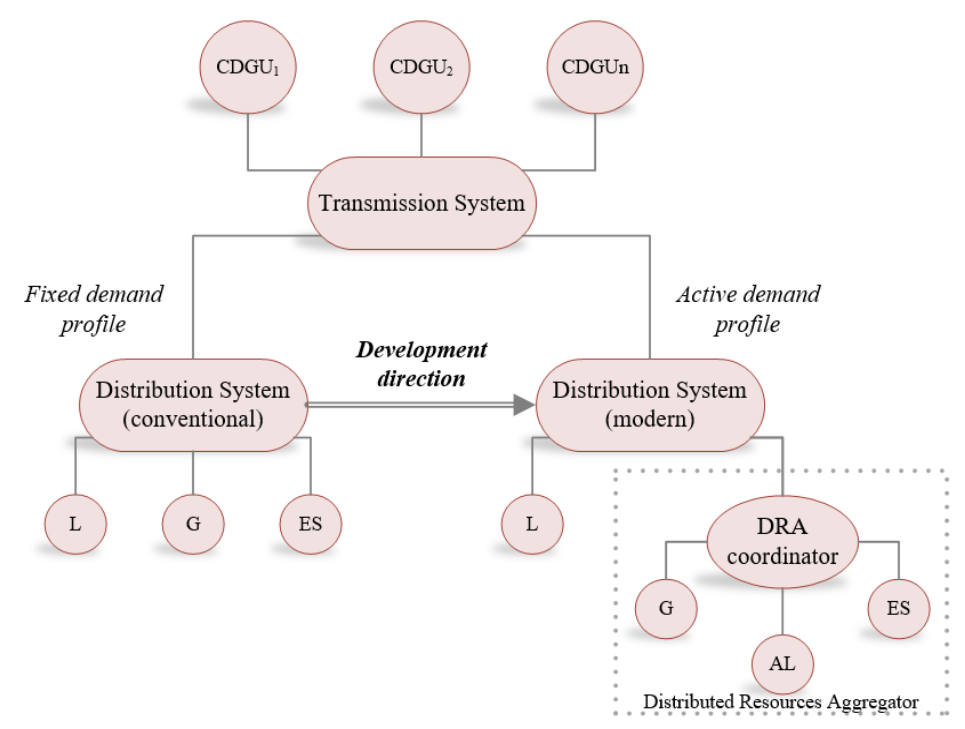
Figure 1. The development of modern power systems and relations between their entities.